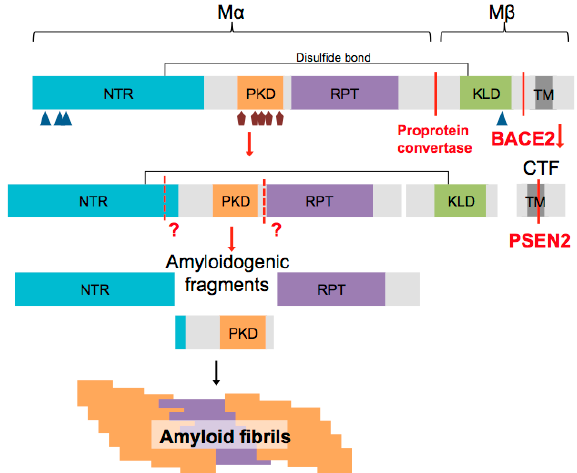
Figure 2. Schematic representation of pre-melanosomal protein (PMEL) protein domain structure. Triangles and pentagons represent N- and O-linked glycosylations, respectively. PMEL cleavage sites and the involved proteases are indicated in red. PMEL amyloid fibril formation requires processing of the amyloidogenic M α fragment into subfragments by still unknown proteases (indicated as ?). Red arrows illustrate proteolytic PMEL processing steps and black arrow represents amyloid formation.